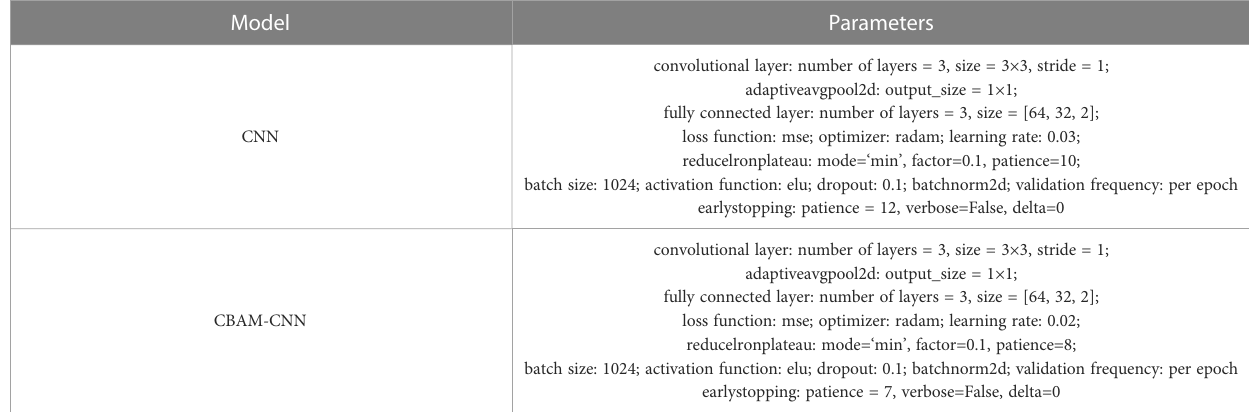
TABLE 2 Optimal combination of parameters of CBAM-CNN and